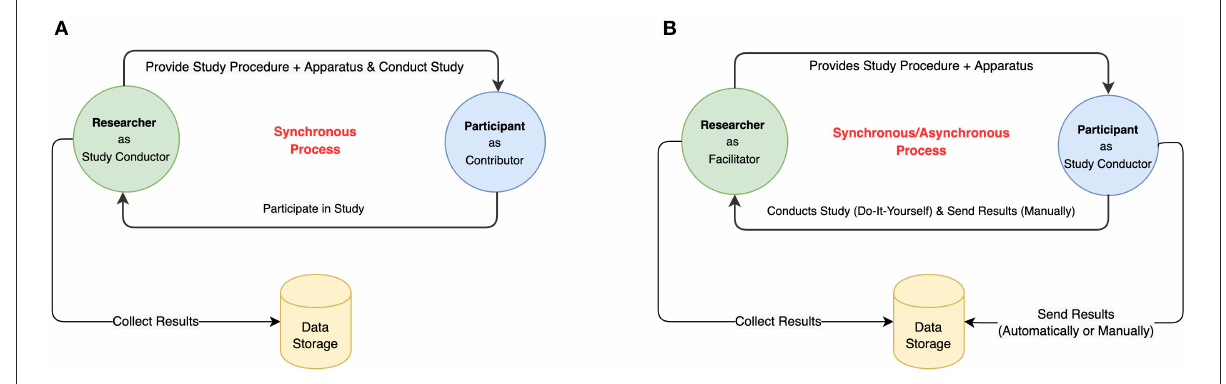
FIGURE1 The nature of the relationship between the researcher and the participant in HCI user studies. (A) Traditional lab-based research studies. (B) Remote research